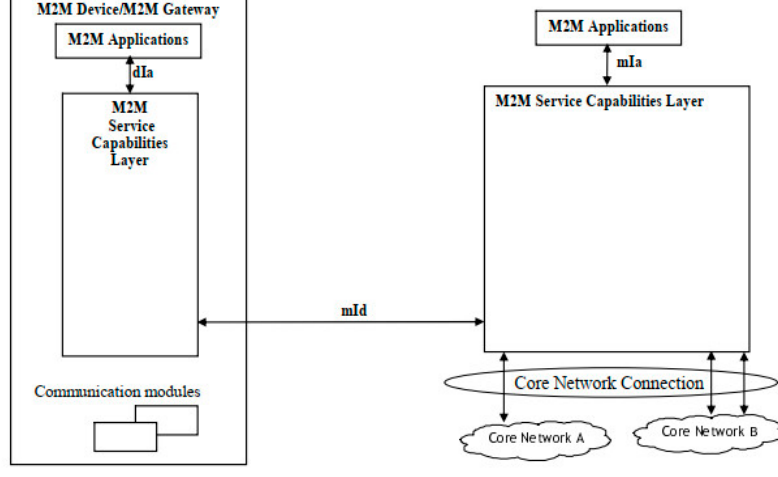
Figure 2. M2M IoT architecture [19].